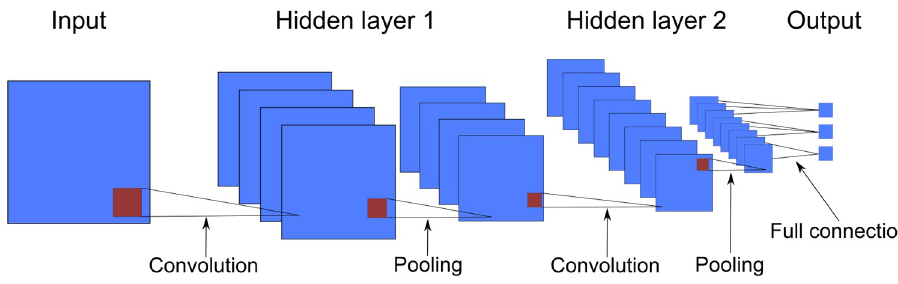
Fig 2. Schematic of a convolutional neural